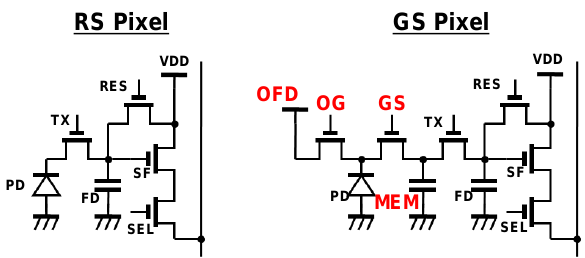
Figure 2. Pixel schematic diagram of RS pixel and GS pixel.